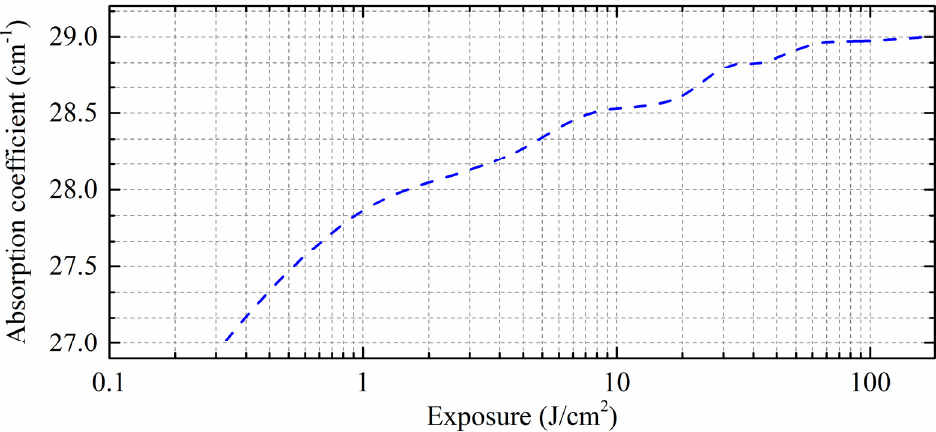
Figure 6. Absorption coefficients of EBT3 film versus ultraviolet (UV) light exposure obtained from our model.